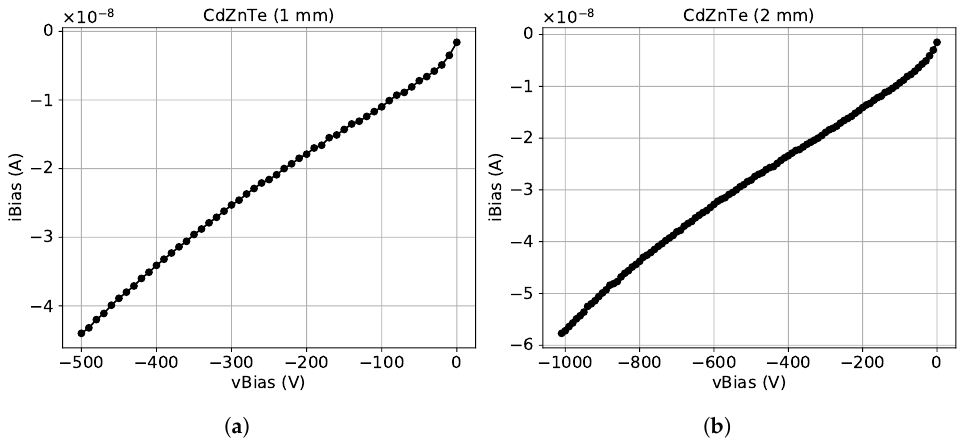
Figure 5. Measured IV-characteristics at room temperature for CdZnTe sensors with 55 µm pixel pitch and a thickness of ( a ) 1 mm and ( b ) 2 mm.